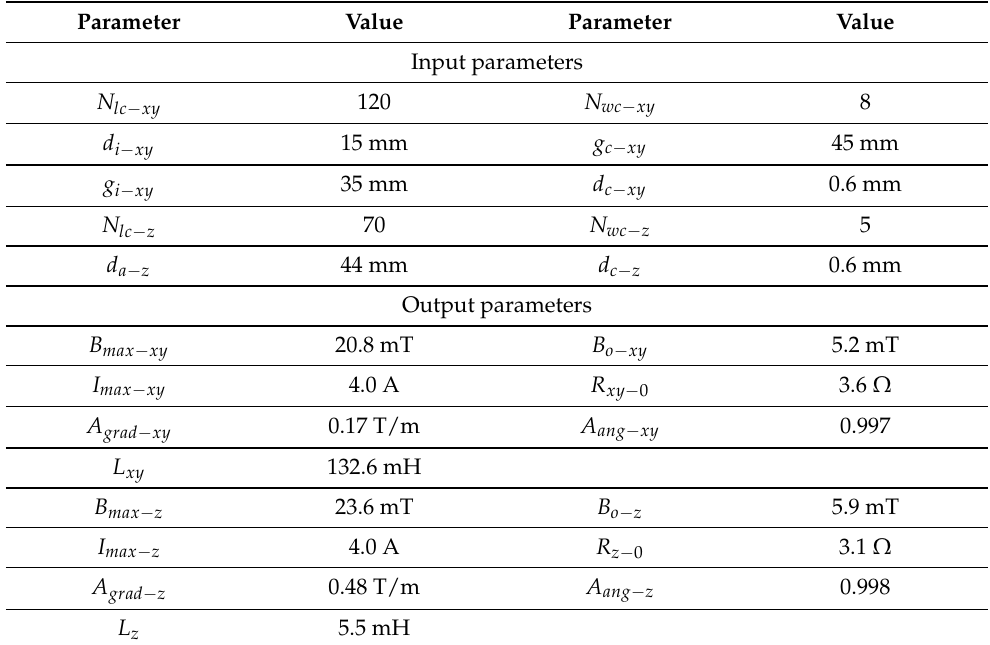
Table 2. Optimization